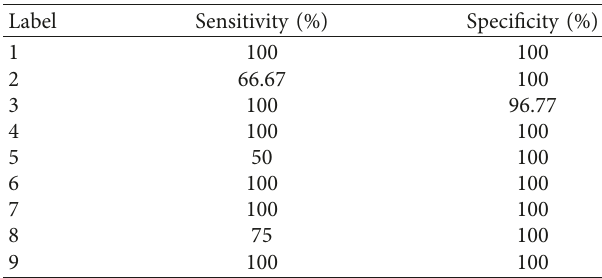
Table 5: The sensitivity and specificity of cluster analysis based on intensity data extracted from spectra pretreated by